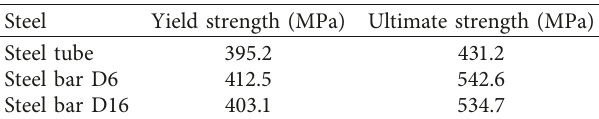
Table 4: Material performance of the steel tube and the reinforcing steel.